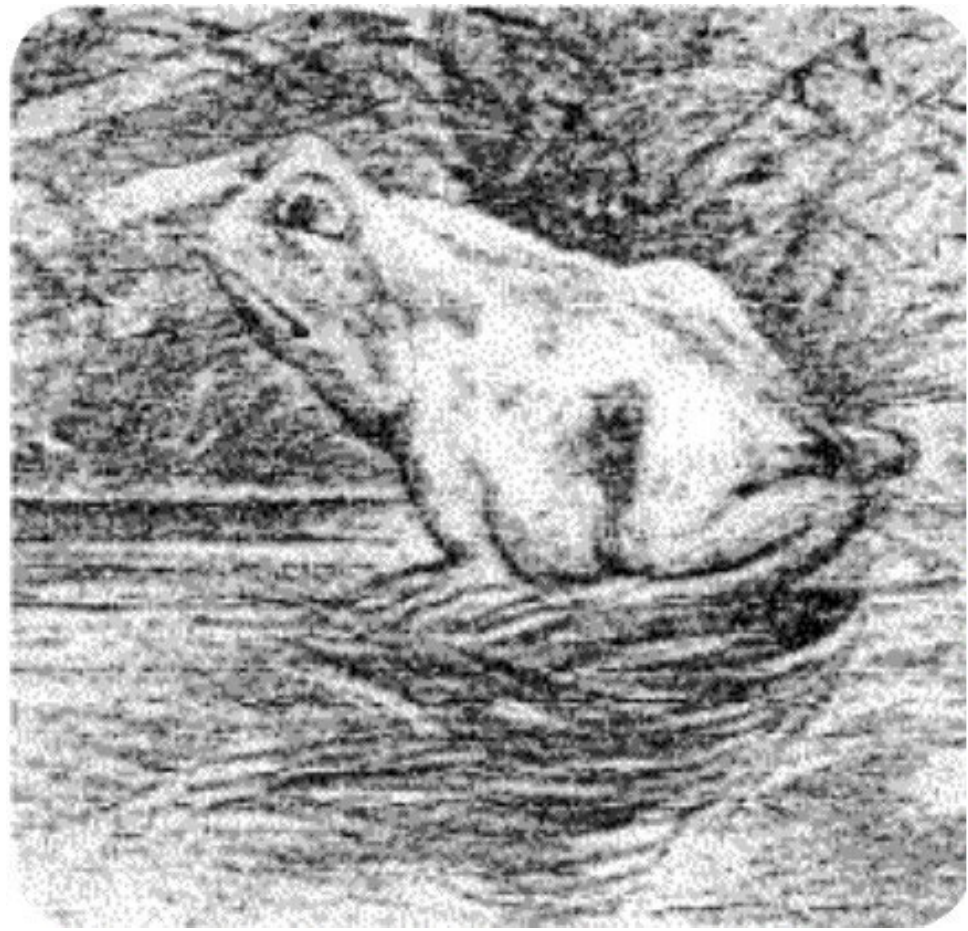
Figure 11. Horse’s head and neck.